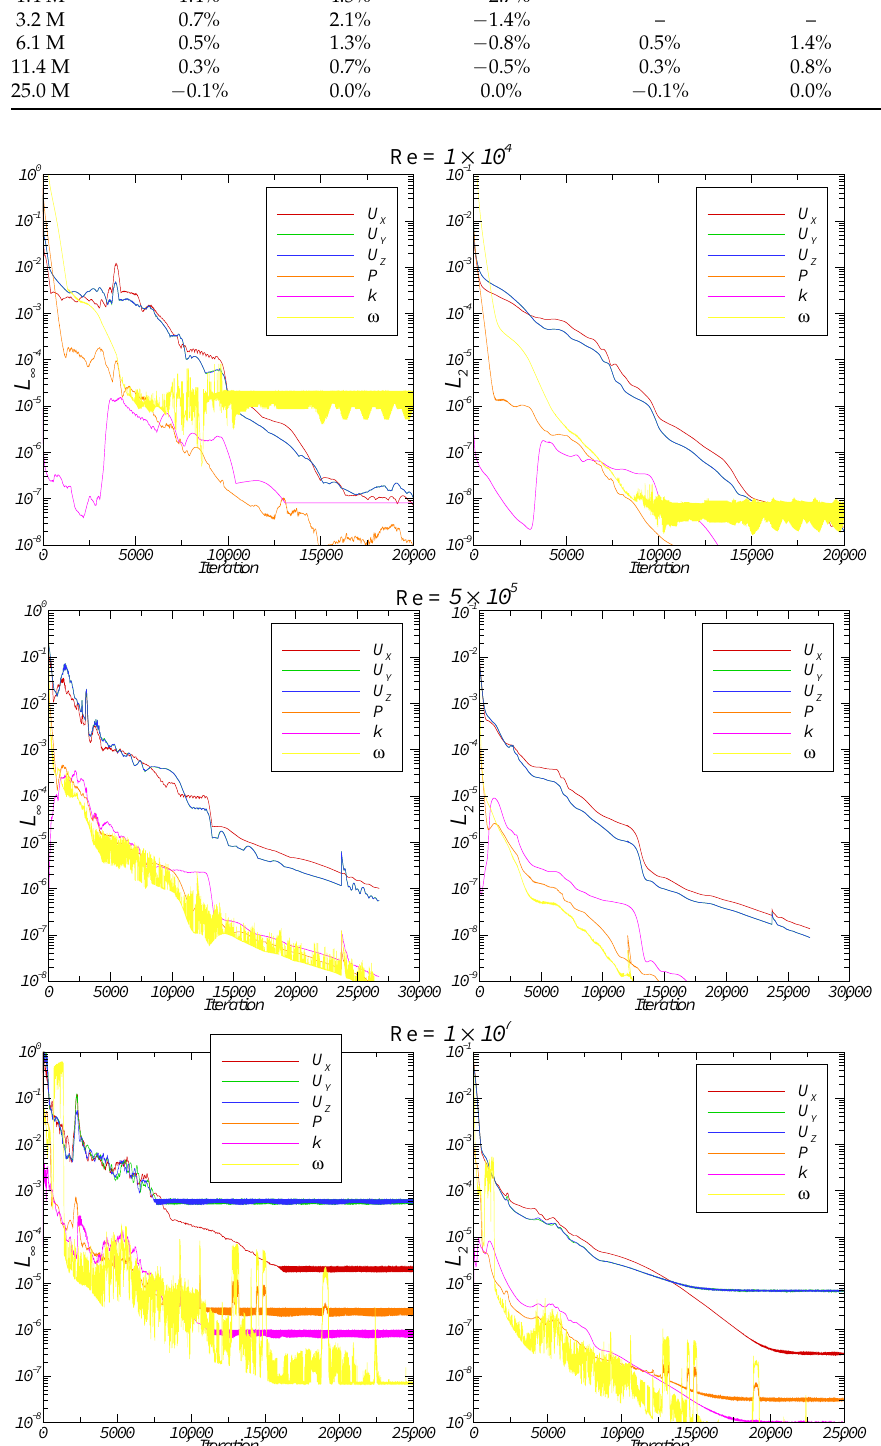
Figure 2. L ∞ ( left ) and L 2 ( right ) iterative convergence at J = 0.568 using the k − ω SST turbulence model. Re = 1 × 10 4 ( top ), 5 × 10 5 ( middle ) and 1 × 10 7 ( bottom